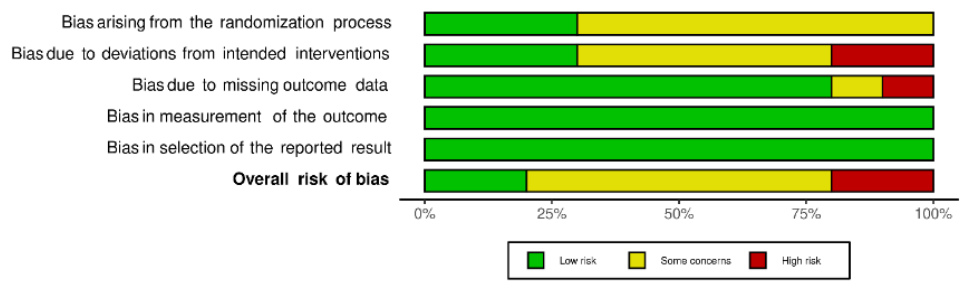
Figure 3. Weighted bars plot of risk of bias evaluation of included studies (Cochrane’s RoB v2.0 tool).